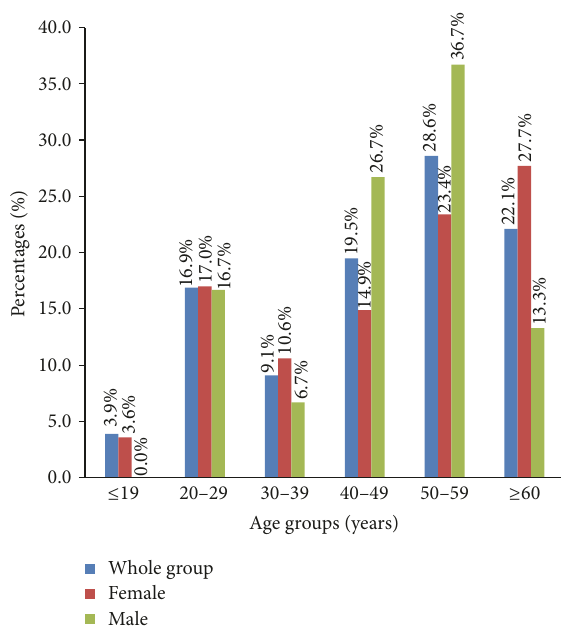
Figure 2: Age characteristics of patients diagnosed with thyroid